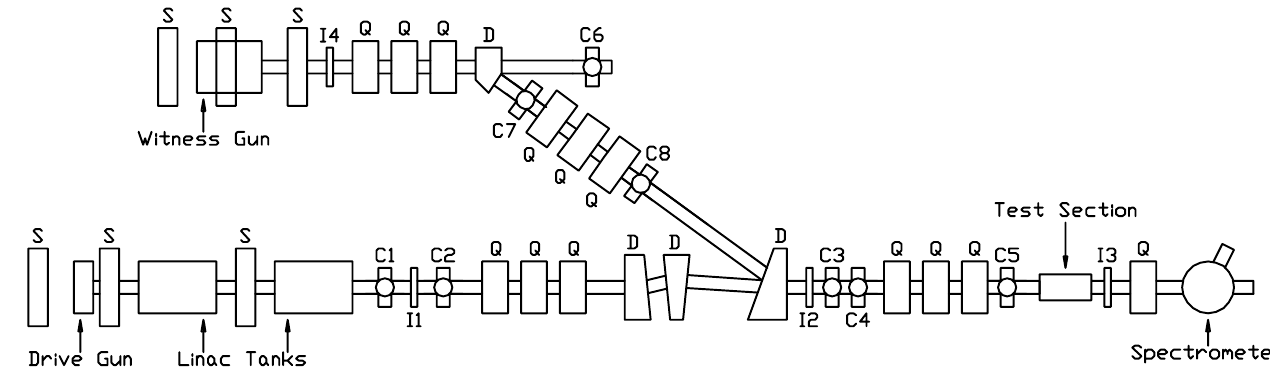
FIG. 1. Schematic of the AWA experimental setup: S, Q, and D indicate solenoids, quadrupoles, and dipoles, respectively; the four integrating current transformers are labeled I1 through I4; the eight diagnostic ports are labeled C1 through C8. Ports C1 and C6 have off axis mirrors that direct the laser beam onto the cathode surface, as well as mirrors that send some of the scattered light off of the cathode to a CCD camera for alignment purposes; all other ports have phosphor targets for electron beam imaging. The aerogel and the pepper-pot plate are located on ports C3 and C4, respectively.